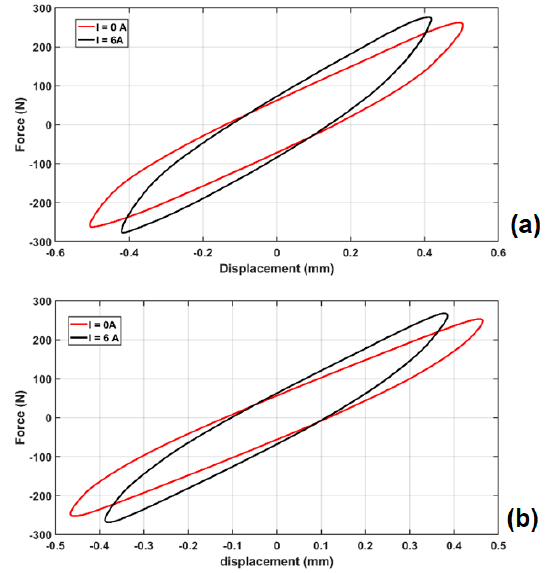
Figure 14. Shear tests: ( a ) f = 5 Hz; and ( b ) f = 10 Hz.